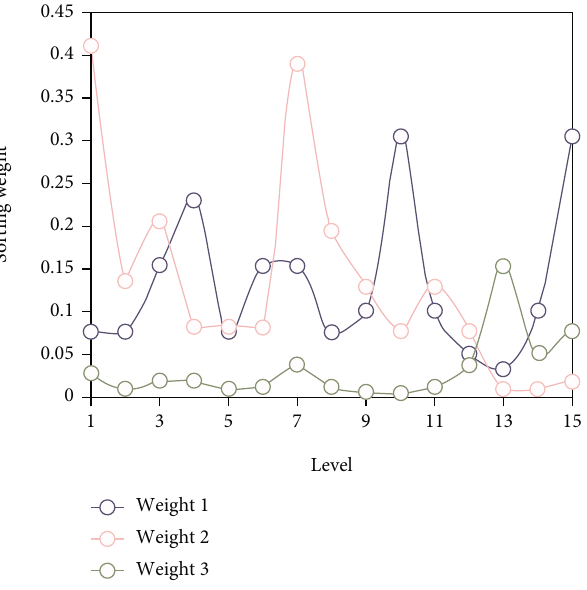
Figure 5: Comprehensive ranking